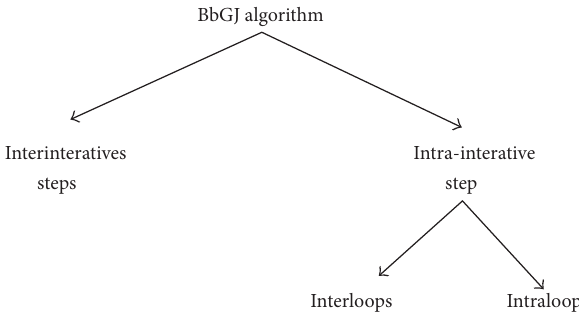
Figure 1: Analysis of parallelism on BbGJ